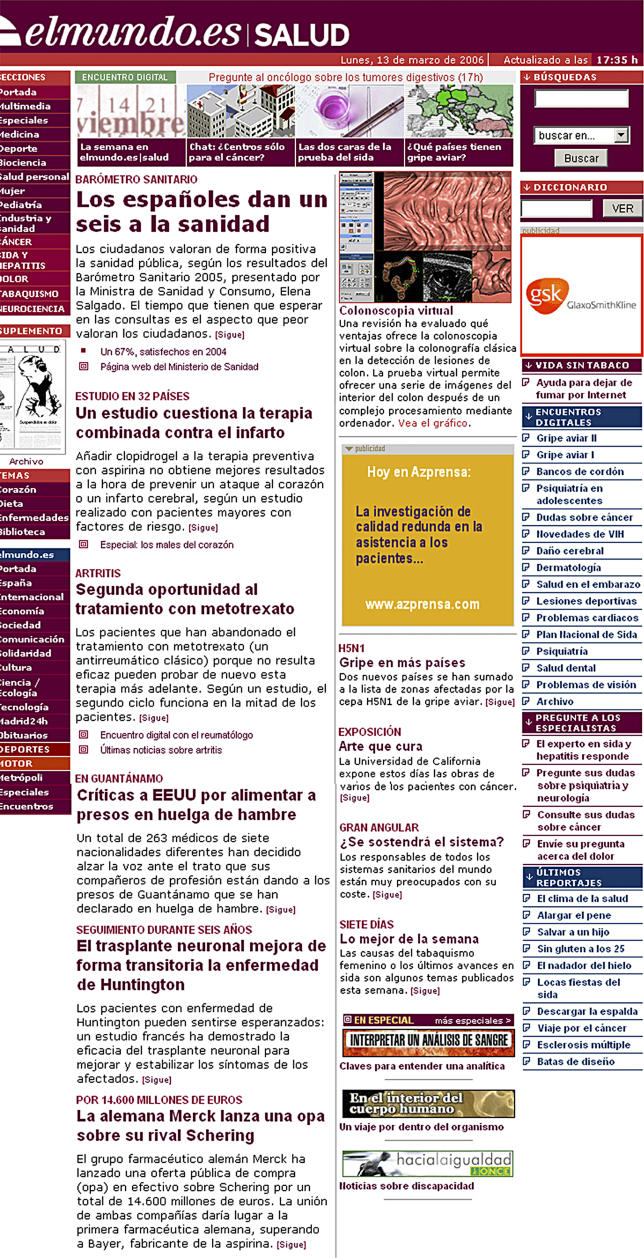
Homepage of
elmundosalud.com